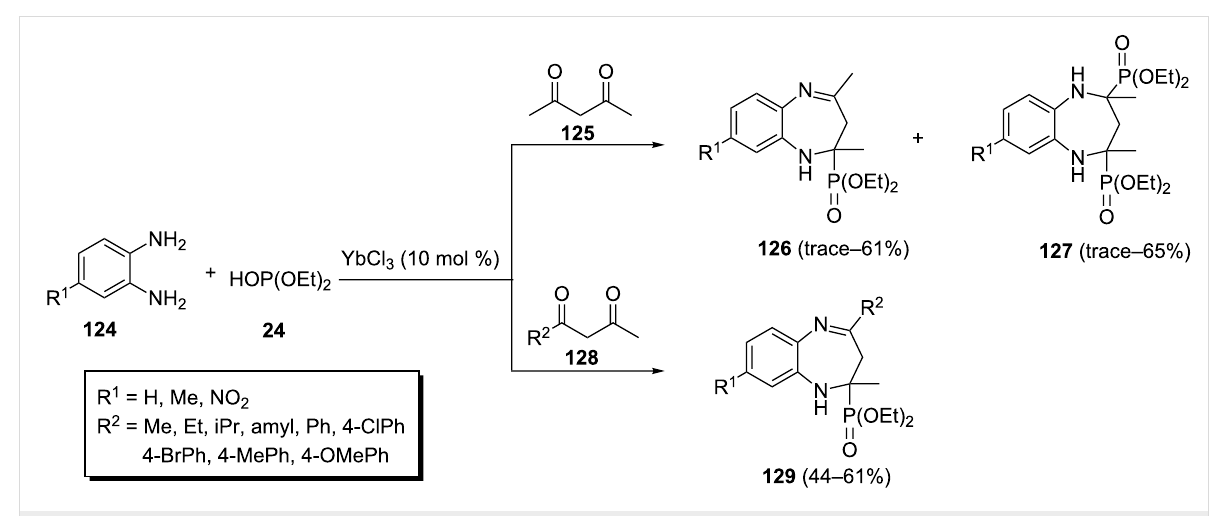
Scheme 27: Synthesis of 1,5-benzodiazepin-2-ylphosphonates via ytterbium chloride-catalyzed three-component